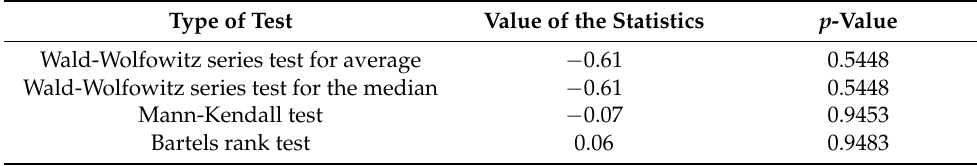
Table 6. Verification of the normality distribution for the ‘theta’ variable. Type of Test Value of the Statistics p -Value Shapiro-Wilk test 0.92 0.2745 Lilliefors